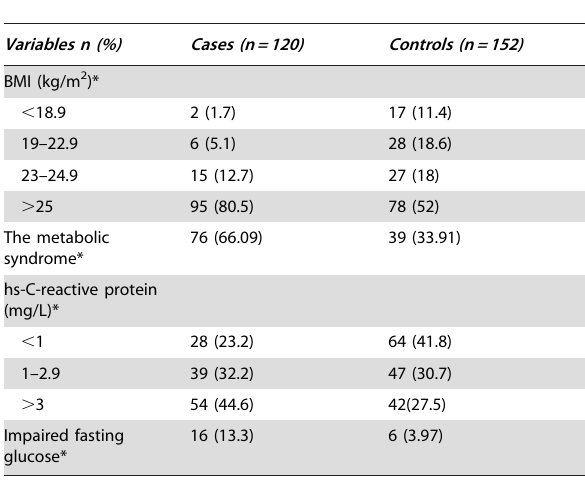
Table 2. Distribution of hs-CRP According to Presence